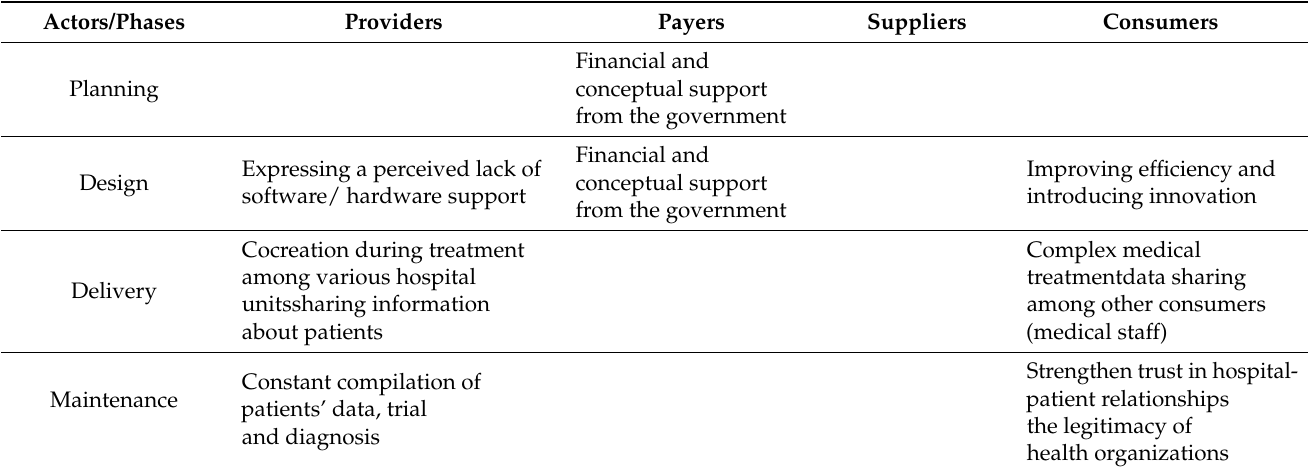
Table 6. Cocreation matrix for EHR in